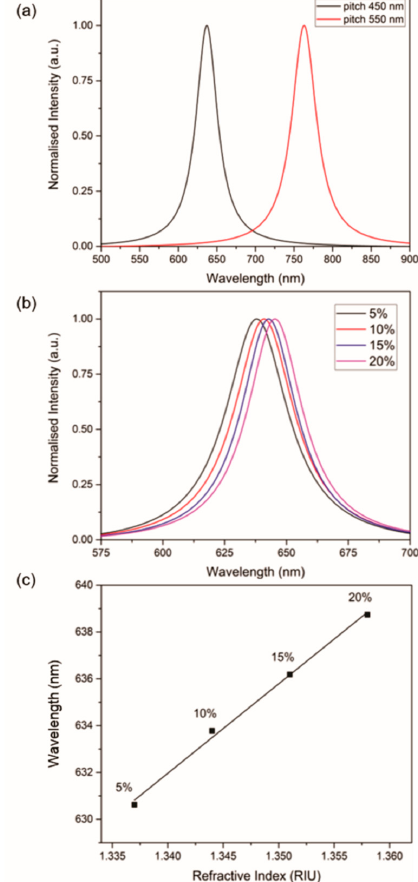
Figure 3. Bulk sensitivity test. ( a ) Normalized surface plasmon resonance (SPR) peaks for water acquired using two different pitch CSRGs (450 nm and 550 nm). ( b ) Normalized SPR peaks for aqueous sucrose solutions of different concentrations (5%, 10%, 15% and 20%). The SPR spectrum shifts toward red as the refractive index increases. ( c ) Wavelength (nm) vs. refractive index (RIU) for each solution. The sensitivity of the platform is 382.2 nm/RIU, based on the slope of the linear fit. No error bars are indicated since the standard deviation for N = 3 is smaller than the size of the symbol representing the mean in the graph.